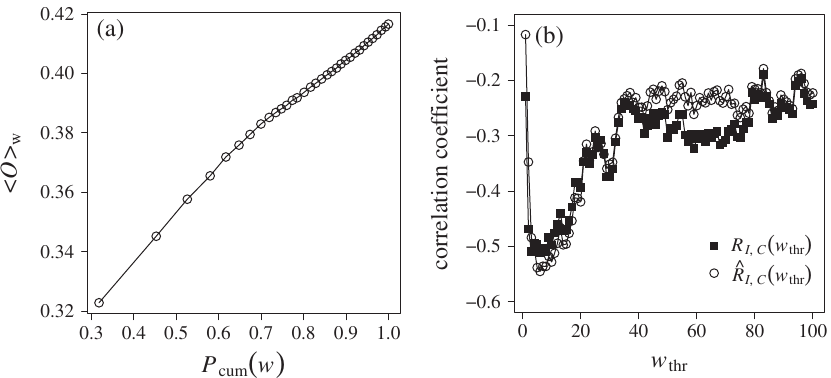
FIG. 11. (a) Averaged neighborhood overlap h O i w as a function of the fraction of links with weights smaller than w for D (b) Pearson correlation coefficient between I i and C i ð w Þ and s ð w Þ fixed (circles), for D with k i ð w i thr thr